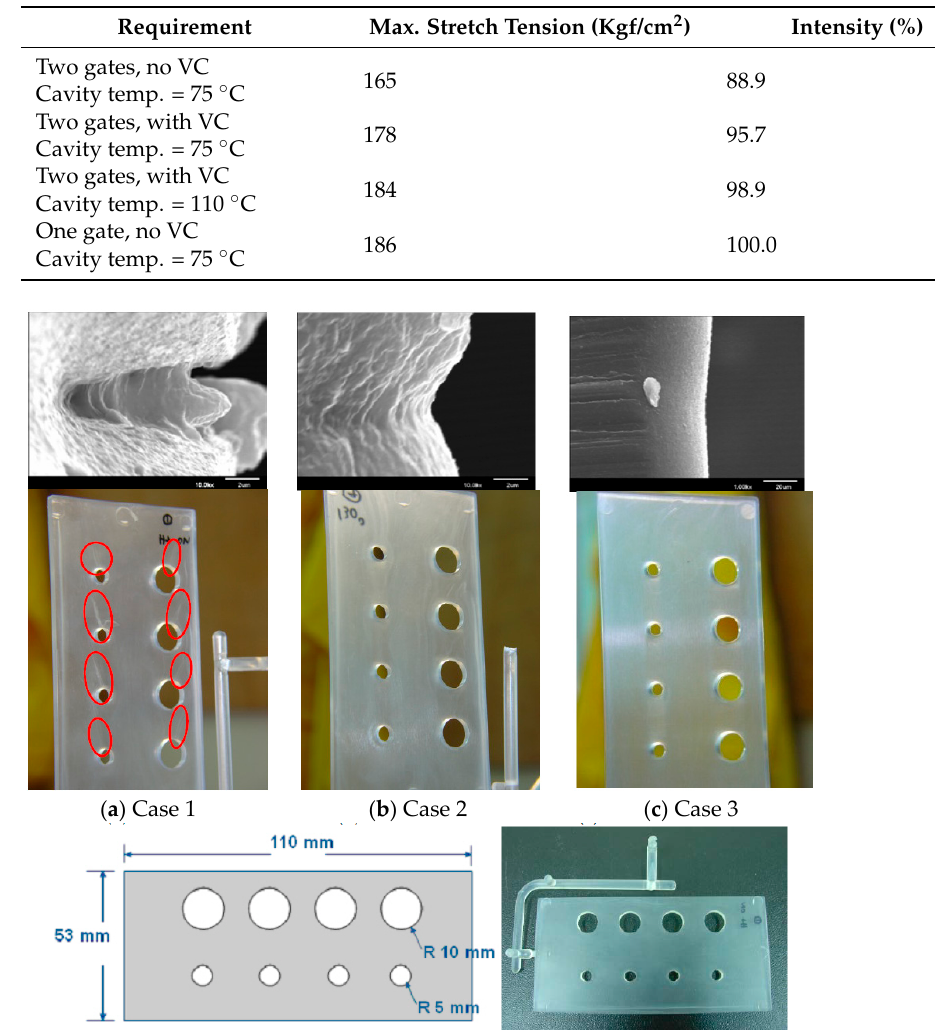
Figure 10. SEM photographs of the eight holes